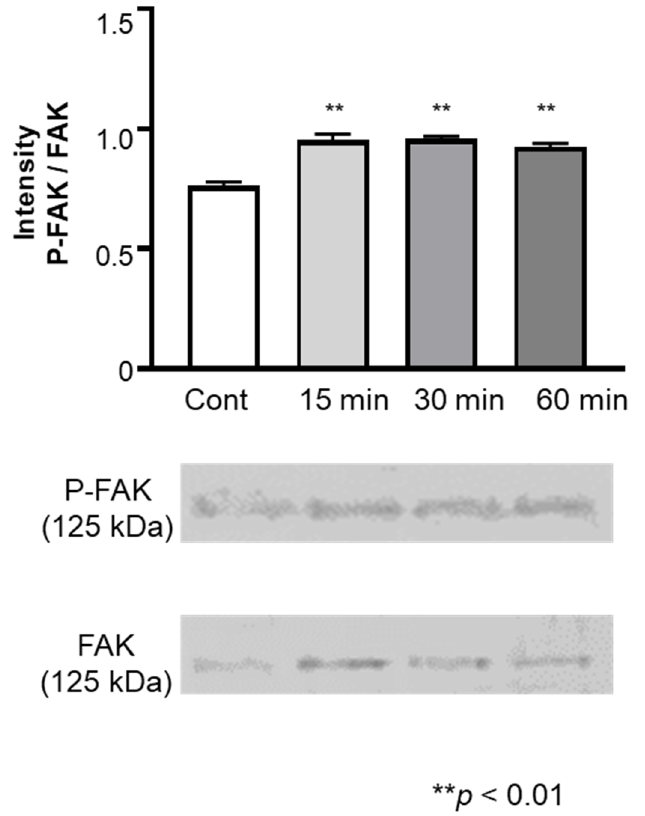
Figure 4. Effect of exposure to vibratory stimulation with an electric toothbrush on the expression of FAK and phosphorylated FAK in gingival fibroblasts. HGnFs were exposed to vibratory stimulation with an electric toothbrush for 15, 30, and 60 min. Each bar indicates mean ± standard deviation (SD) of three independent experiments. ** p < 0.01.